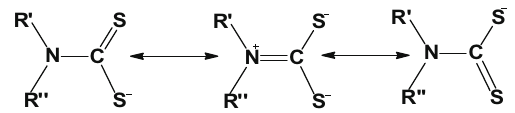
Figure 1: Resonance structure of the dithiocarbamate anion ( II ) [ 14 ] .